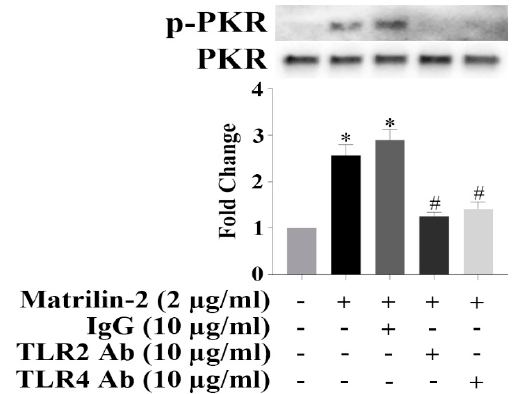
Figure 4. Both toll-like receptor (TLR) 2 and 4 mediate matrilin-2-induced PKR activation in human AVICs. Human AVICs were treated with TLR2-neutralizing antibody or TLR4-neutralizing antibody for 1 h or left untreated, followed by stimulation with recombinant matrilin-2. Neutralization either TLR2 or TLR4 attenuated matrilin-2-induced PKR phosphorylation. Values are means ± SE. n = 3 separate experiments; * P < 0.05 vs. control; # P < 0.05 vs. matrilin-2 alone.